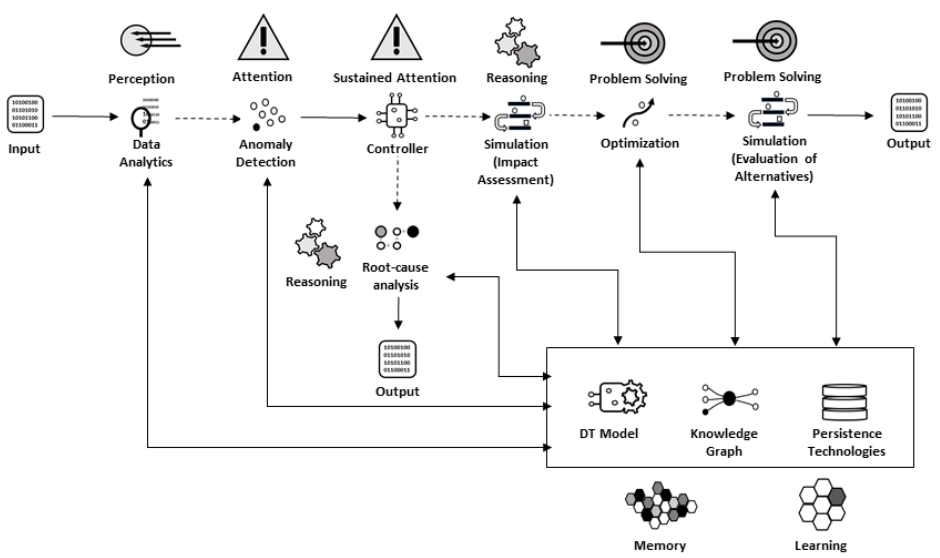
Figure 4. Paths to resilience and cognitive services.